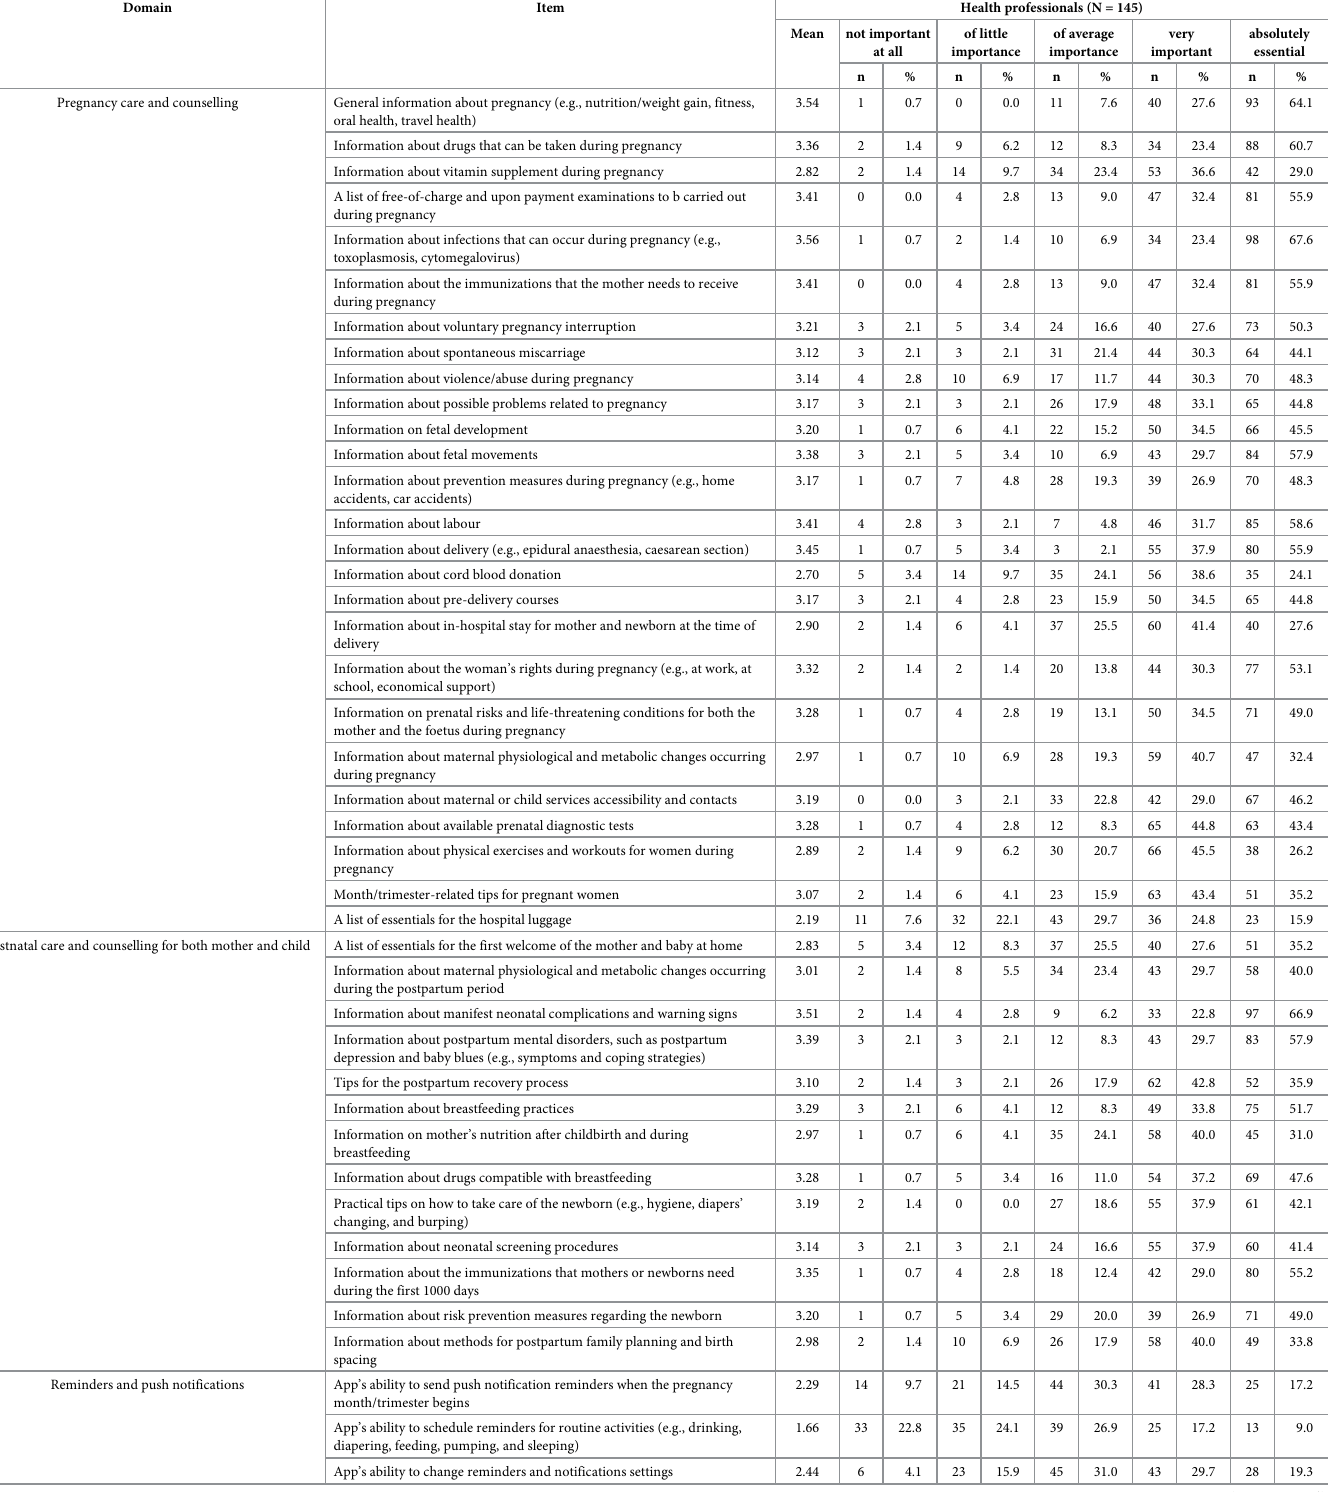
Table 3. Ratings from health professionals regarding the contents, functionalities, and technical features of the proposed app. Domain